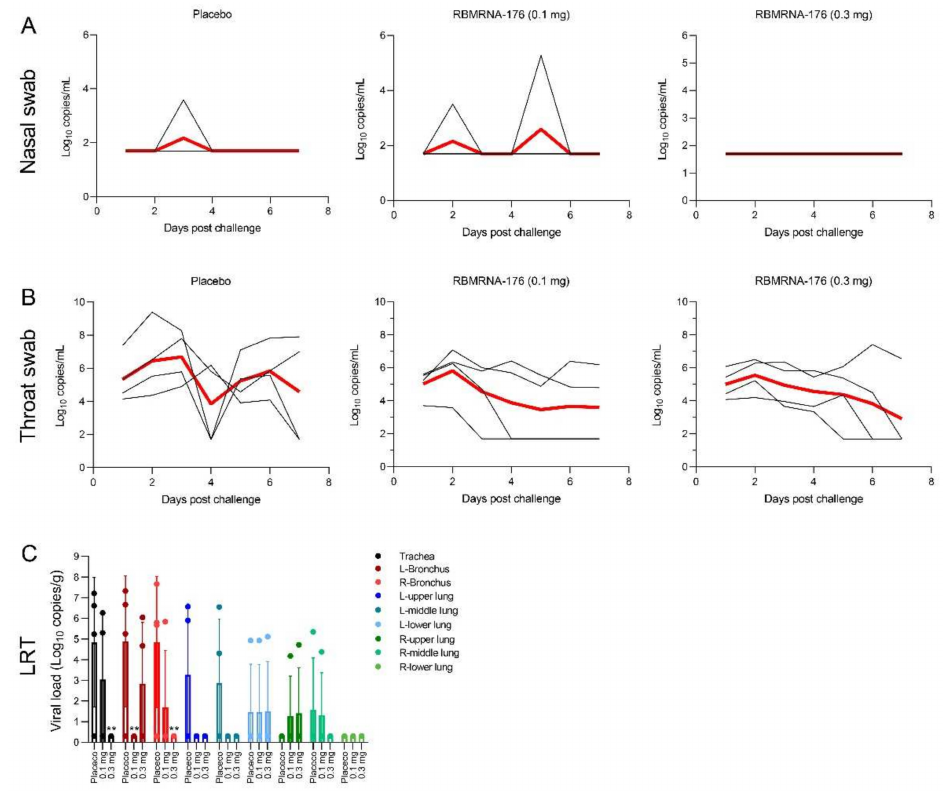
Figure 8. Viral load in respiratory tract tissues of SARS-CoV-2-infected rhesus macaques with RBMRNA-176 vaccination. RBMRNA-176-vaccinated rhesus macaques were intranasally